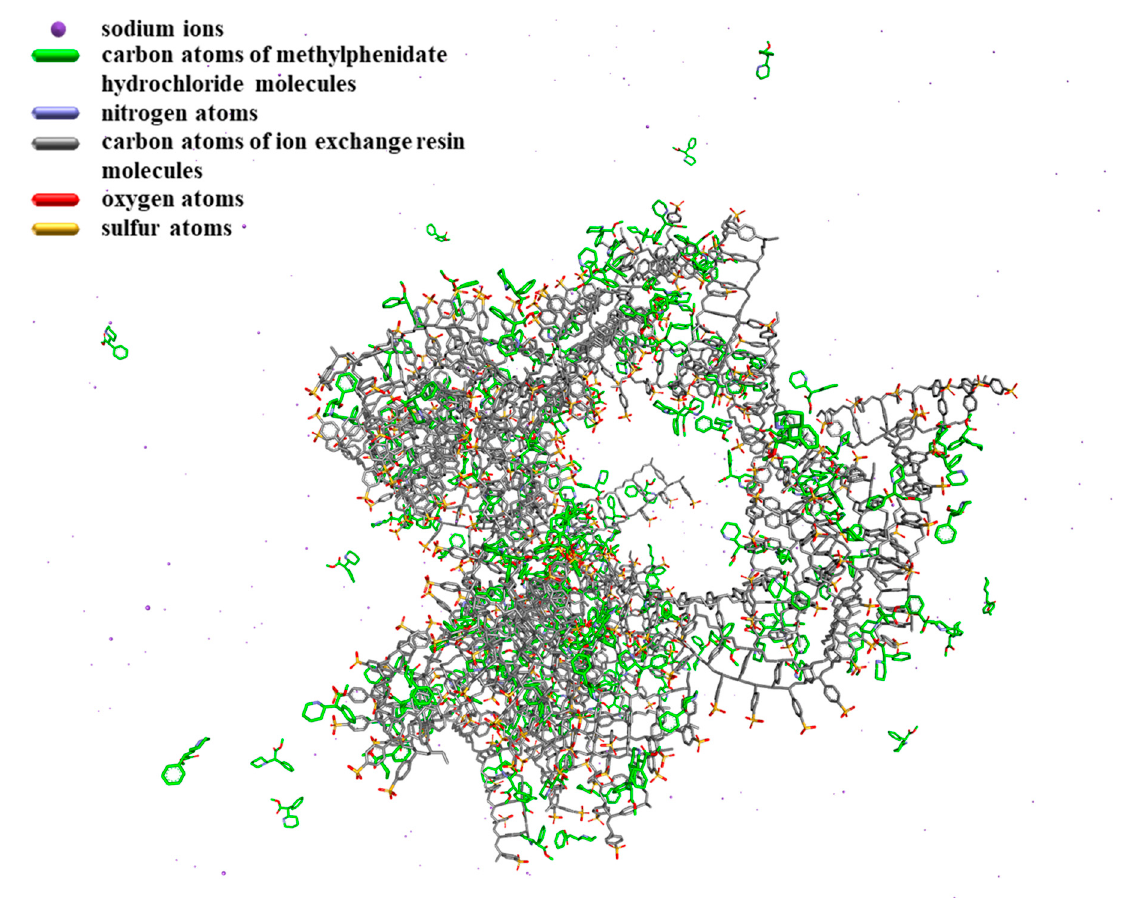
Figure 10. The conformation of the system of methylphenidate hydrochloride and ion exchange resins.